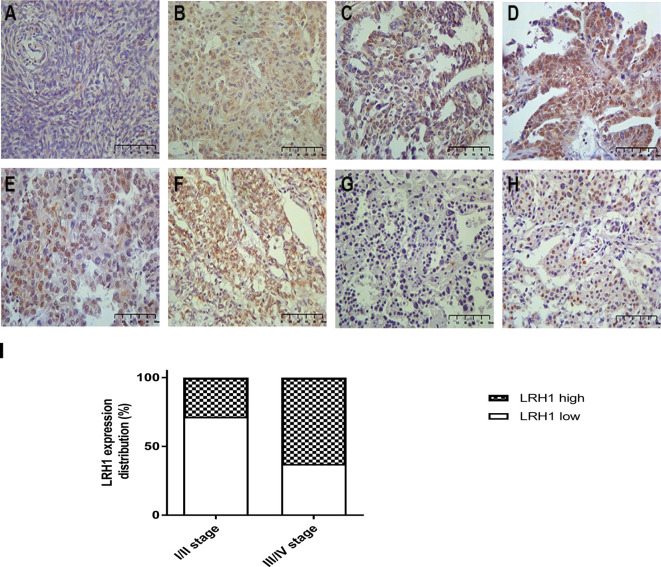
Immunohistochemical analysis of LRH1 protein expression (×400). (A) negative or weak expression in normal ovarian tissues; (B) high expression in primary ovarian cancer (OC) tissues (observed mainly in nucleus, a few in cytoplasmic); (C) low expression in serous histotypes (mainly in nucleus); (D) high expression in serous histotypes (mainly in nucleus, a few in cytoplasmic); (E) high expression in mucinous histotypes (mainly in nucleus); (F) high expression in endometrioid histotypes (mainly in nucleus, a few in cytoplasmic); (G) negative or low expression in clear cell histotypes; (H) high expression in clear cell histotypes (mainly in nucleus, scarcely in cytoplasmic); (I) the status of LRH1 expression in different FIGO stages.